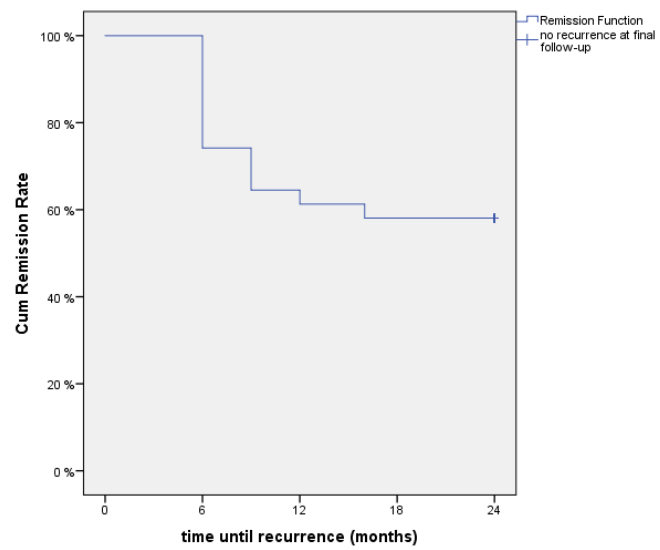
Figure 3. The time until recurrence of symptoms is displayed using a Kaplan–Meier plot resulting in a cumulative remission rate function.